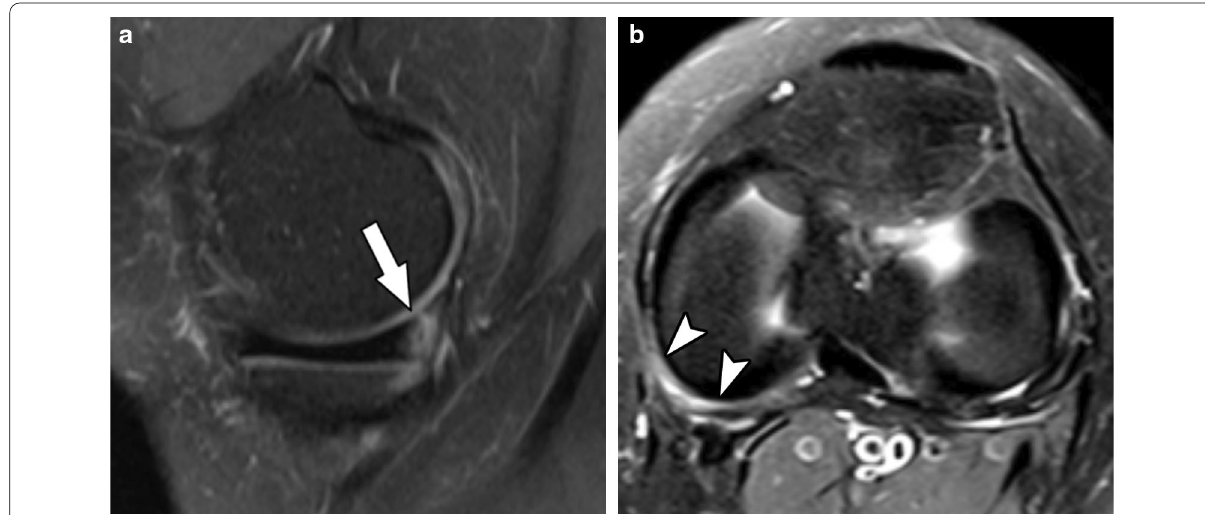
Fig. 3 Type 1 meniscal ramp lesion MRI Case. Sagittal ( a ) and axial T2‑weighted fat‑suppressed images show meniscocapsular tear (arrow) with tibial bone bruise, and the extension of meniscocapsular junction edema